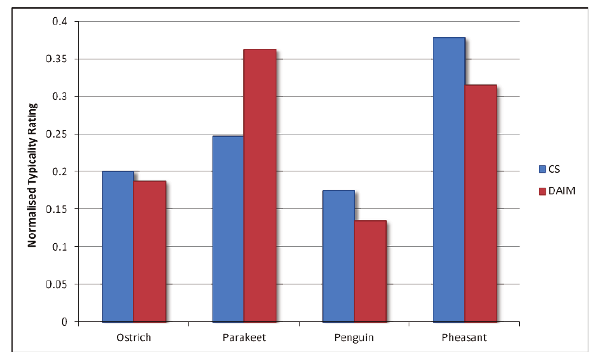
Figure 7. Comparing the relative typicality of four birds, for both DAIM and CS. All four were correctly classified as birds by both models; this shows that for both models parakeet and pheasant are more typical birds than penguin and